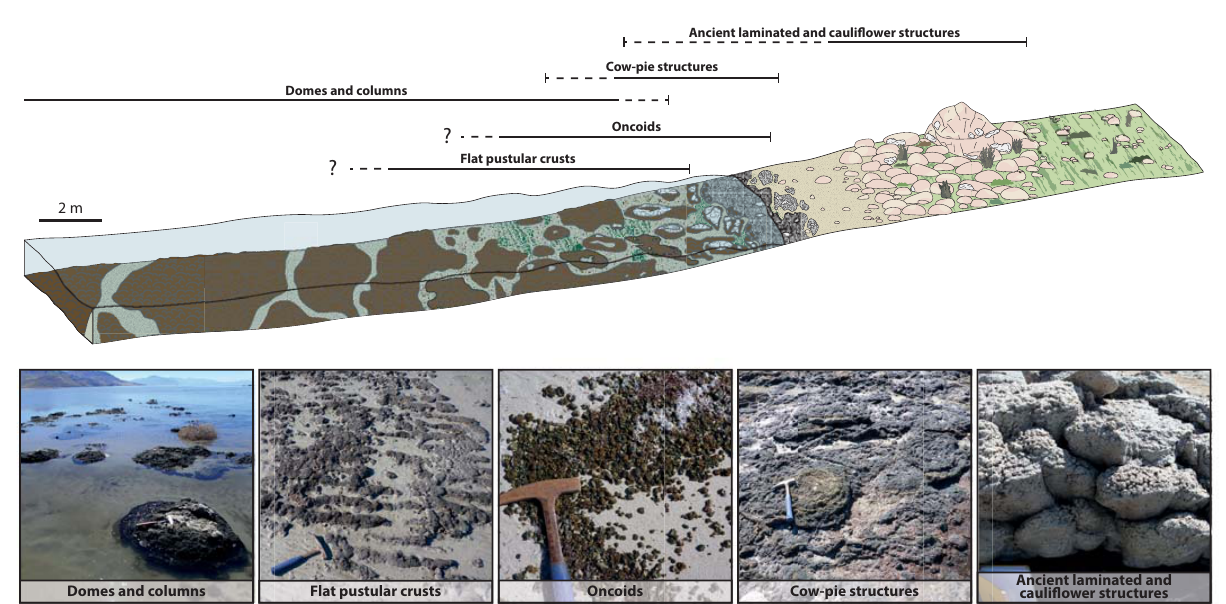
Figure 2. Shore-to-lake transect depicting the position of the microbial macrofabrics used for mapping.